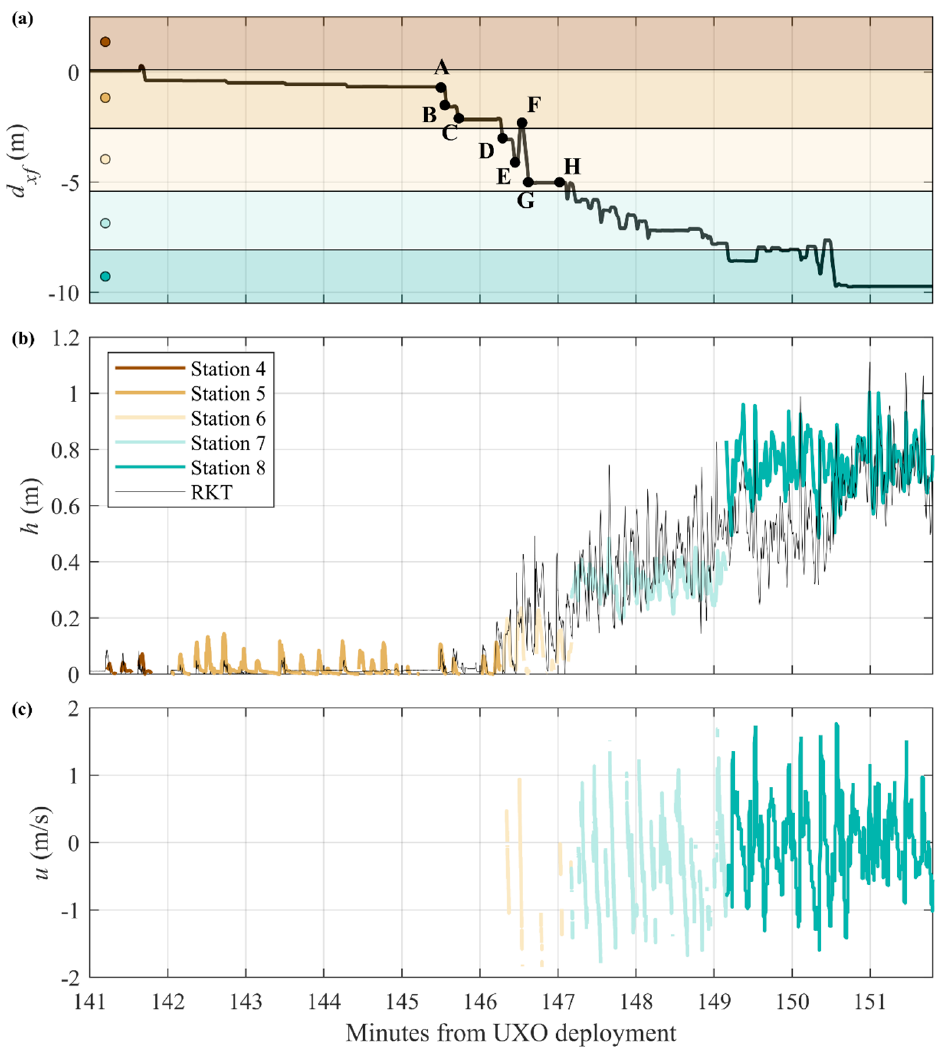
Figure 17. Mobility of the instrumented RKT deployed at x f = 27.1 m and y f = 8.2 m on 24 August. ( a ) IMU cross-shore trajectory of relative distance (solid black line) and cross-shore locations of measuring stations 4–8 (circles, the color scheme follows panel b legend) referenced to 27.1 m. ( b ) Water depth measurements (RBR) at stations 4–8 and at the munition location (PT). ( c ) Cross-shore flow velocities relative to stations 4–8 (Vectrino and JFE).